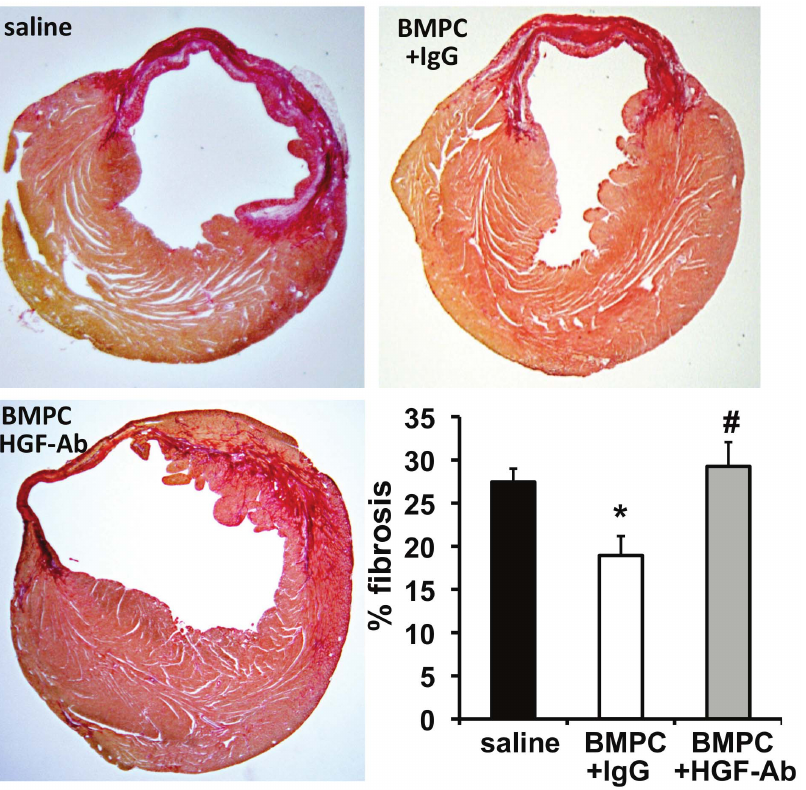
Figure 4. Cardiac fibrosis in db/db mice receiving BMPC therapy. Fibrosis area was determined at 28 days after MI by Sirius red staining. Collagen stains deep red and normal tissue stains yellowish. BMPC therapy decreased % fibrosis in comparison with saline-treated group. Administration of neutralizing antibodies against HGF (HGF-Ab) significantly aggravated fibrosis as compared to IgG treated group. Bar graph represents quantification of percent fibrosis area (percentage of LV area). HGF-Ab indicates antibodies against hepatocyte growth factor; BMPC, bone marrow-derived progenitor cell. BMPC, bone marrow-derived progenitor cell. *P , 0.05 vs saline group; # P , 0.05 versus IgG treated group.